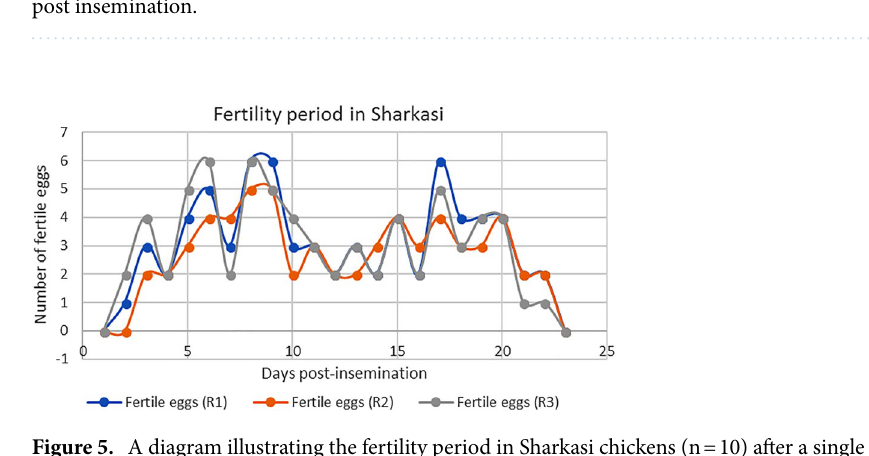
Figure 5. A diagram illustrating the fertility period in Sharkasi chickens (n = 10) after a single insemination. The experiment was repeated 3 times. Sharkasi chickens continued laying fertile eggs for 22 days post